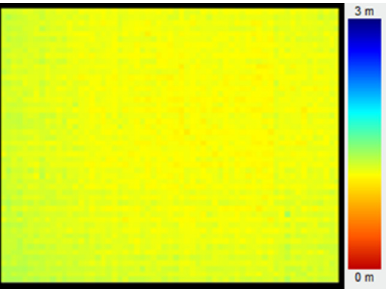
Figure 5. Depth image without distance response non-uniformity (DRNU) compensation.